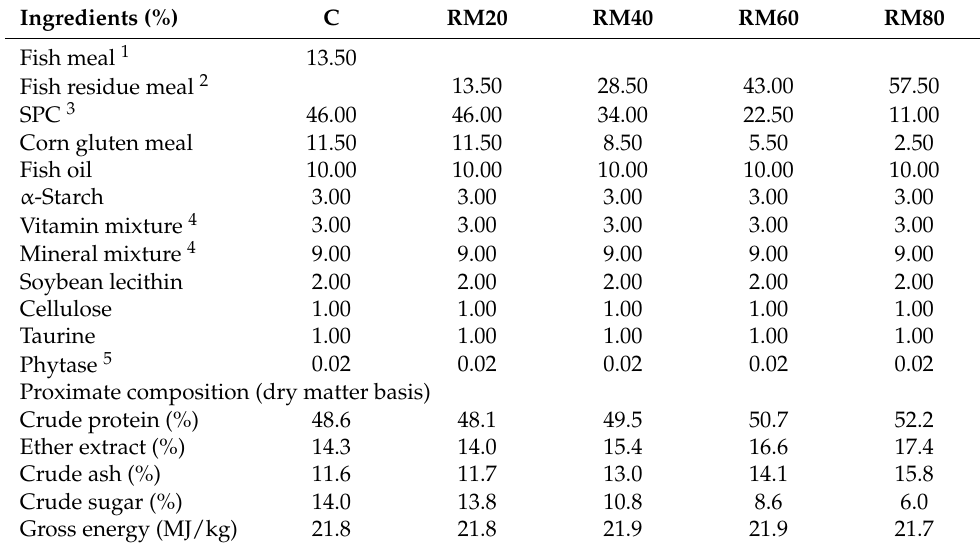
Table 2. Formulation and proximate composition of experimental diets used in Trial